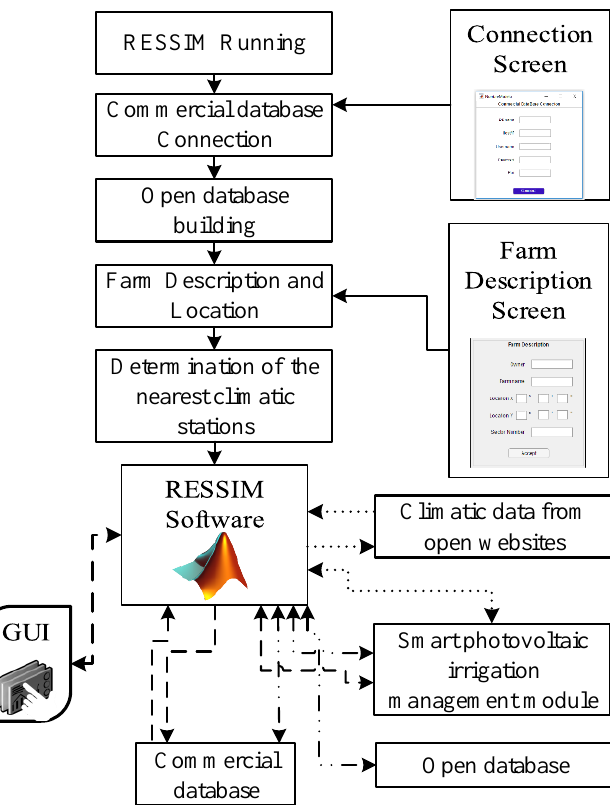
Figure 3. Chart flow of RESSIM.